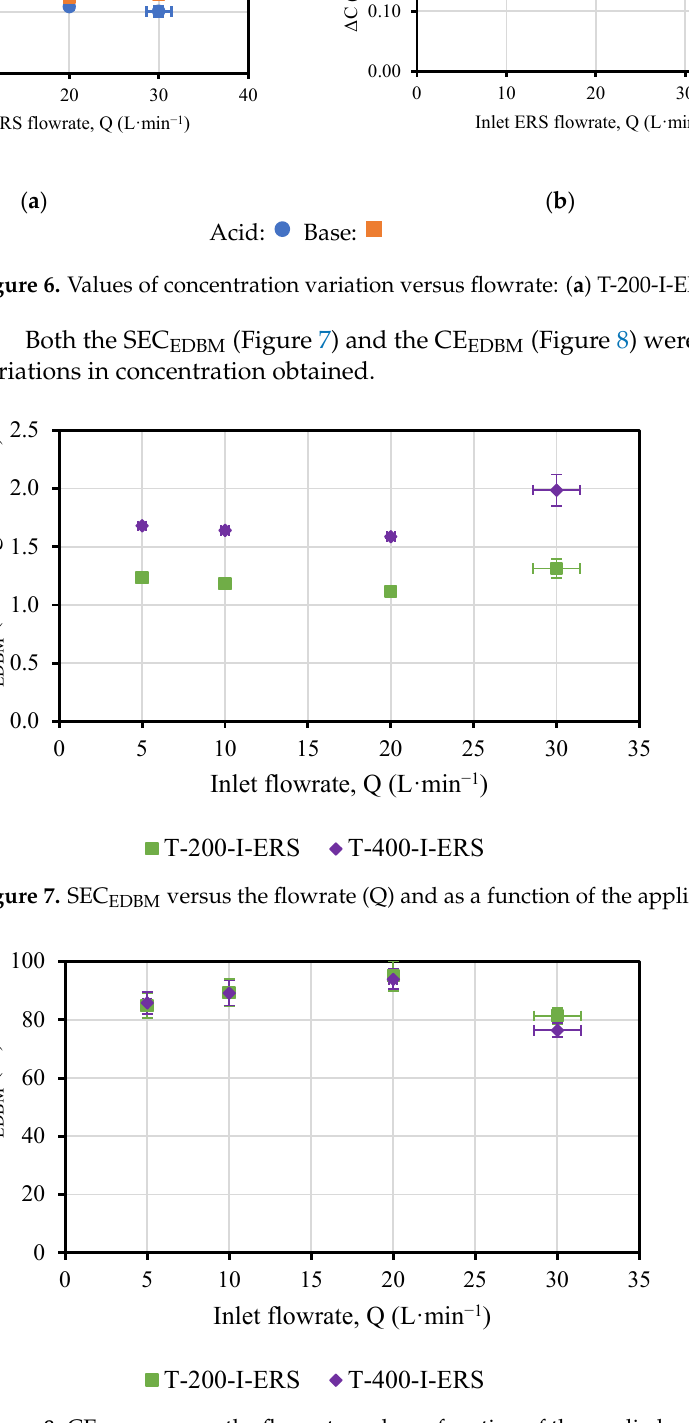
Figure 8. CE EDBM versus the flowrate and as a function of the applied current density. ( a ) T ‐ 200 ‐ I ‐ ERS; ( b ) T ‐ 400 ‐ I ‐ ERS. A minimum in the SEC EDBM was observed for the flowrate of 20 L · min − 1 (nominal flowrate) for both T-200-I-ERS and